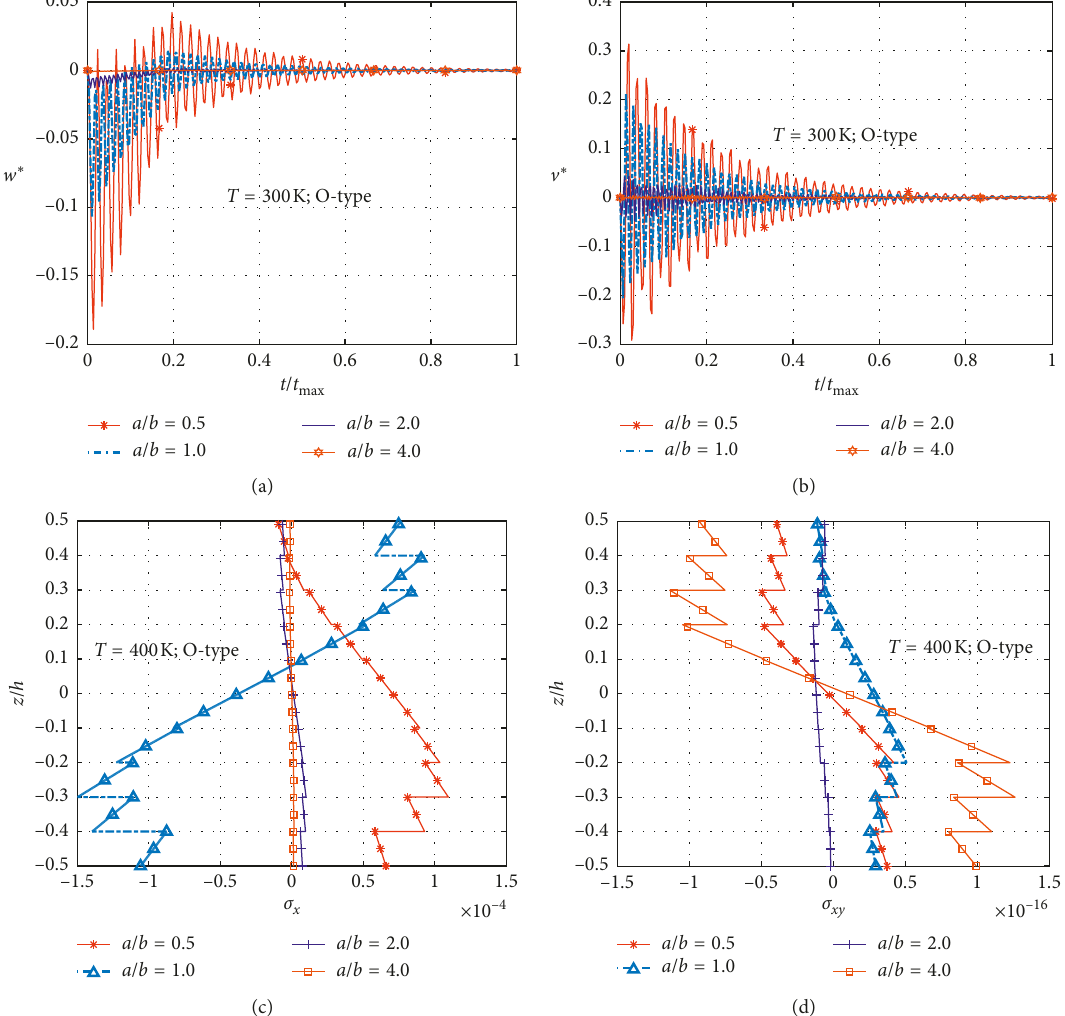
300K of O-type shell: (cid:31)